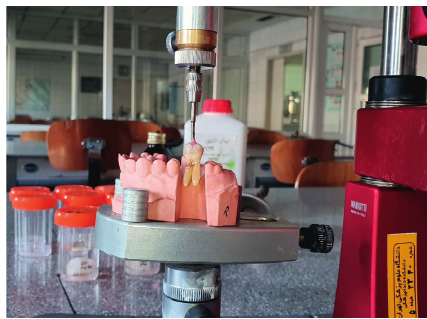
Figure 1: The process of mounting tooth specimen using a surveyor (the tooth is not in its final position).